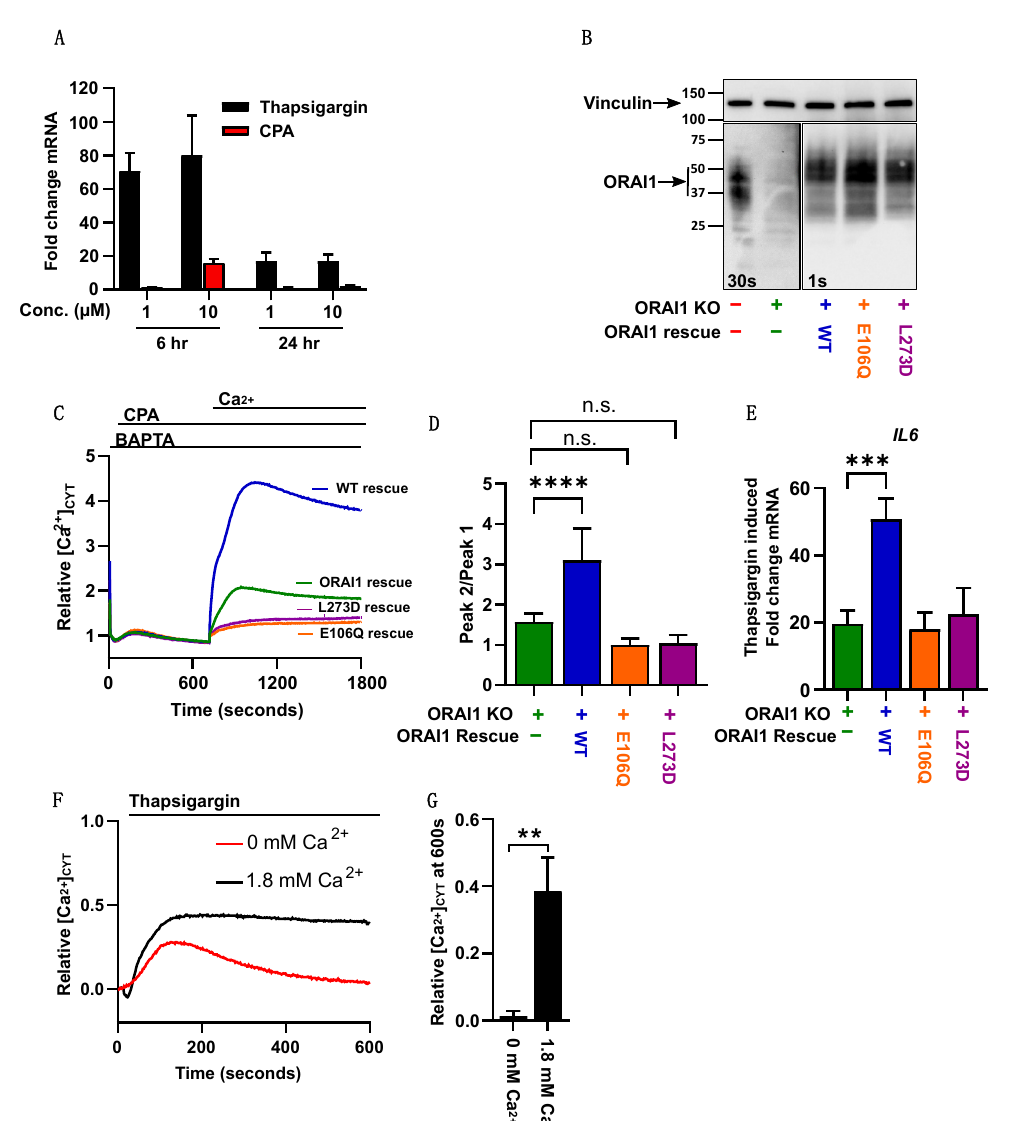
Figure 4. ORAI1 regulates IL6 expression in MDA-MB-468 cells. ( A ) Bar graphs showing IL6 mRNA level measured by RT-qPCR following treatment of MDA-MB-468 ORAI1 WT rescue cells with two concentrations of thapsigargin and CPA, at two different time points, from three independent experiments represented as mean ± SD. ( B ) Representative immunoblot showing endogenous ORAI1 expression in MDA-MB-468 parental cells; ORAI1 knockout cells; and rescue with ORAI1 WT, ORAI1 E106Q, and ORAI1 L273D overexpression in MDA-MB-468 ORAI1 knockout cells.( C ) Representative traces of store-operated calcium entry in MDA-MB-468 parental cells (red), ORAI1 knockout cells (green), ORAI1 WT (blue), ORAI1 E106Q (orange), and ORAI1 L273D (purple). ( D ) Bar graphs showing peak2/peak1 (SOCE) from six independent experiments and representing mean ± SD (n.s., not significant ( p ≥ 0.05); **** p < 0.0001, one-way ANOVA with Dunnett’s post-hoc). ( E ) Bar graphs showing IL6 mRNA fold change induced by 6 h treatment with thapsigargin from five independent experiments and representing mean ± SD (*** p < 0.001, one-way ANOVA with Dunnett’s post-hoc). ( F ) Representative traces in MDA-MB-468 cells showing Ca 2+ influx induced by thapsigargin in the absence (0 mM) or presence (1.8 mM) of extracellular Ca 2+ from three independent experiments. ( G ) Bar graph showing the relative cytoplasmic calcium concentration at 600 s from three independent experiments and representing mean ± SD (** p < 0.001, t